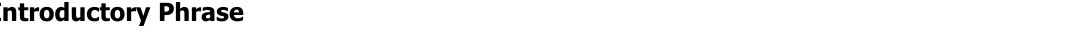
Table 2. Census questions on disability endorsed by the Washington